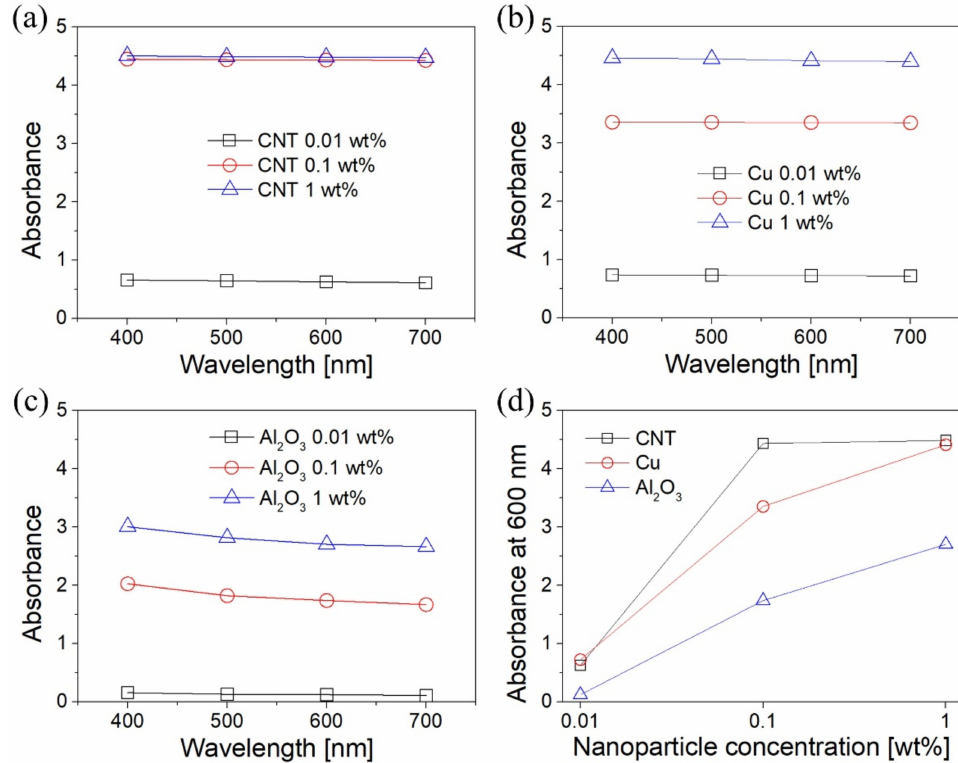
Figure 5. Vis absorbance spectra of nanofluids with three different nanoparticle concentrations (where “1 wt.%” indicates distilled water 99 wt.% + 1 wt.% of a certain type of nanoparticles). ( a ) Multiwalled carbon nanotube, ( b ) Cu, ( c ) Al 2 O 3 , and ( d ) absorbance at 600